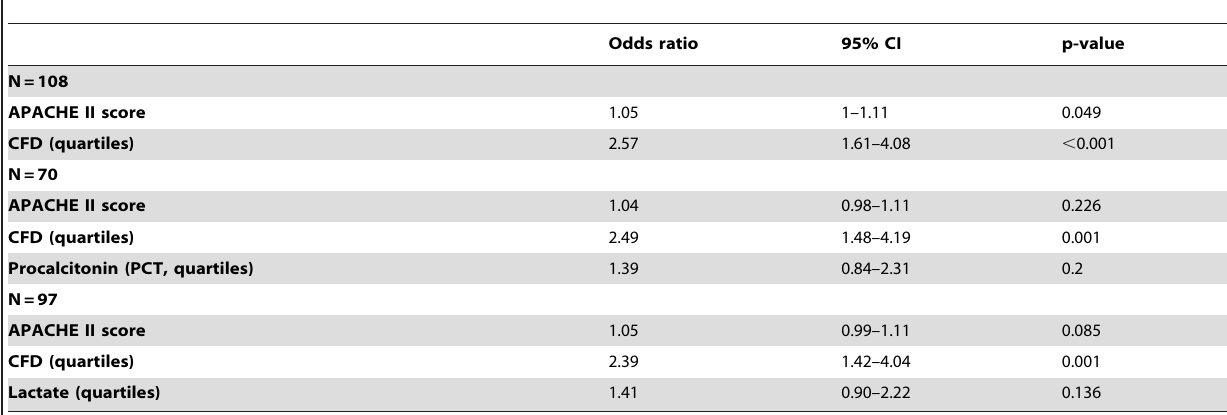
Table 2. Logistic regression model of in-hospital and 28-day mortality in patients with severe sepsis.